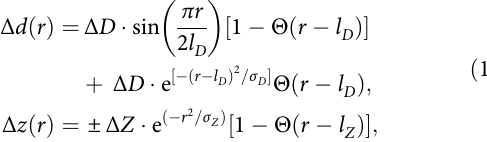
Fig. 2 Pseudo-Landau levels in the deformed twisted bilayer graphene with θ ¼ 0 : 48 (cid:1) . a Linear fi t of the equation E N / pseudo magnetic fi elds is about 9 T. b Calculated LDOS at AA region under the external magnetic fi elds, in which we can con fi rm the splittings of the pseudo-Landau level due to the break of the